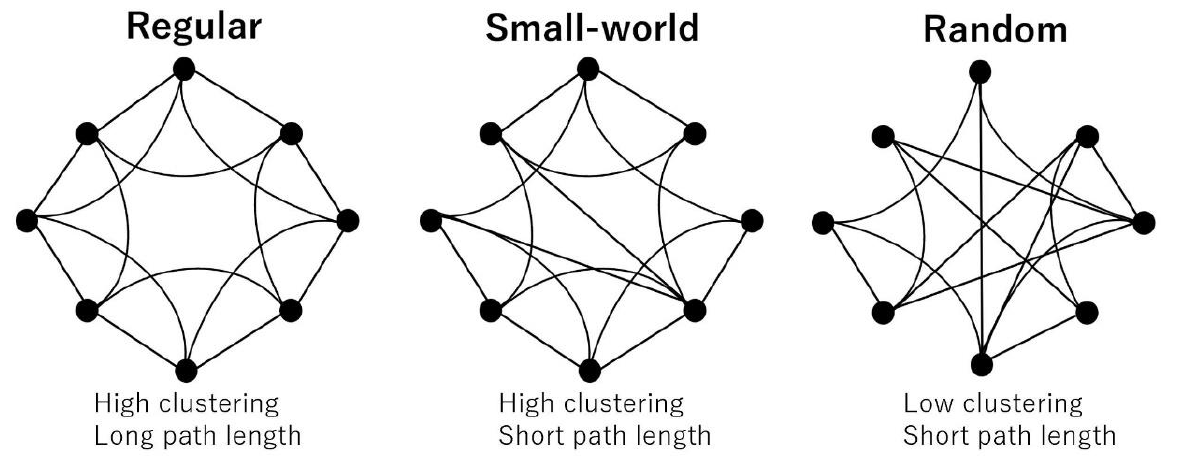
Figure 3. Small-world network model. A regular network has high clustering and long path length, while a random network has low clustering and short path length. A small-world network lies between regular and random, showing high clustering and short path length (many short-range connections coexist with a few long-range connections).